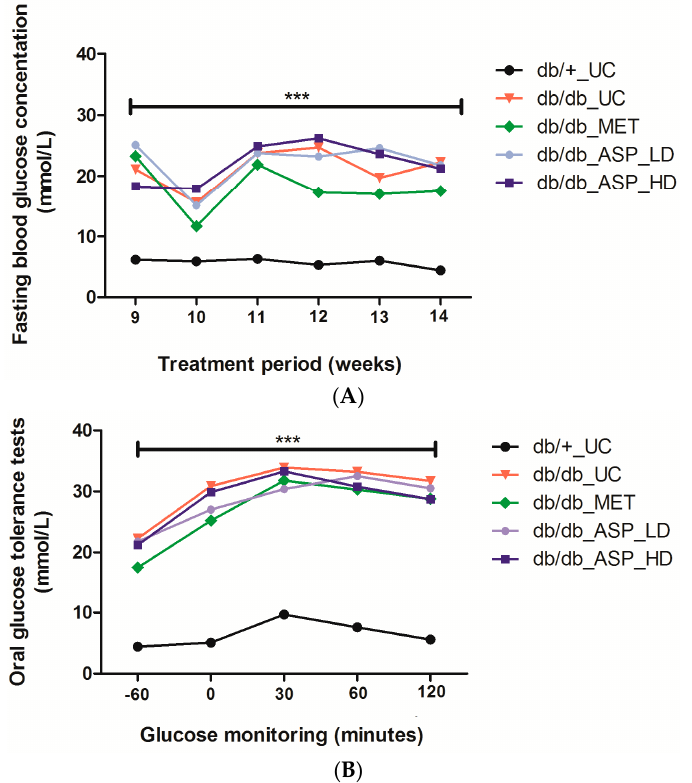
Figure 3. Aspalathin (ASP) treatment did not reduce increasing fasting plasma glucose (FPG) levels, however a high dose of 130 mg/kg of ASP was able to improve oral glucose tolerance in diabetic mice after 60 and 120 minutes from baseline. ( A ) FPG levels ( B ) Oral glucose tolerance tests ( − 60: baseline reading). Results are expressed as the mean ± SEM and each treatment group contained six